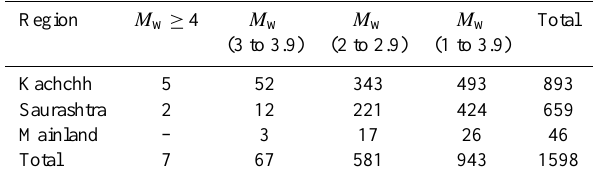
Table 1. Earthquakes recorded in the year 2008 in the three regions of Gujarat by GS-Net (Ref. Annual Report ISR-Gujarat, 08-09, available online